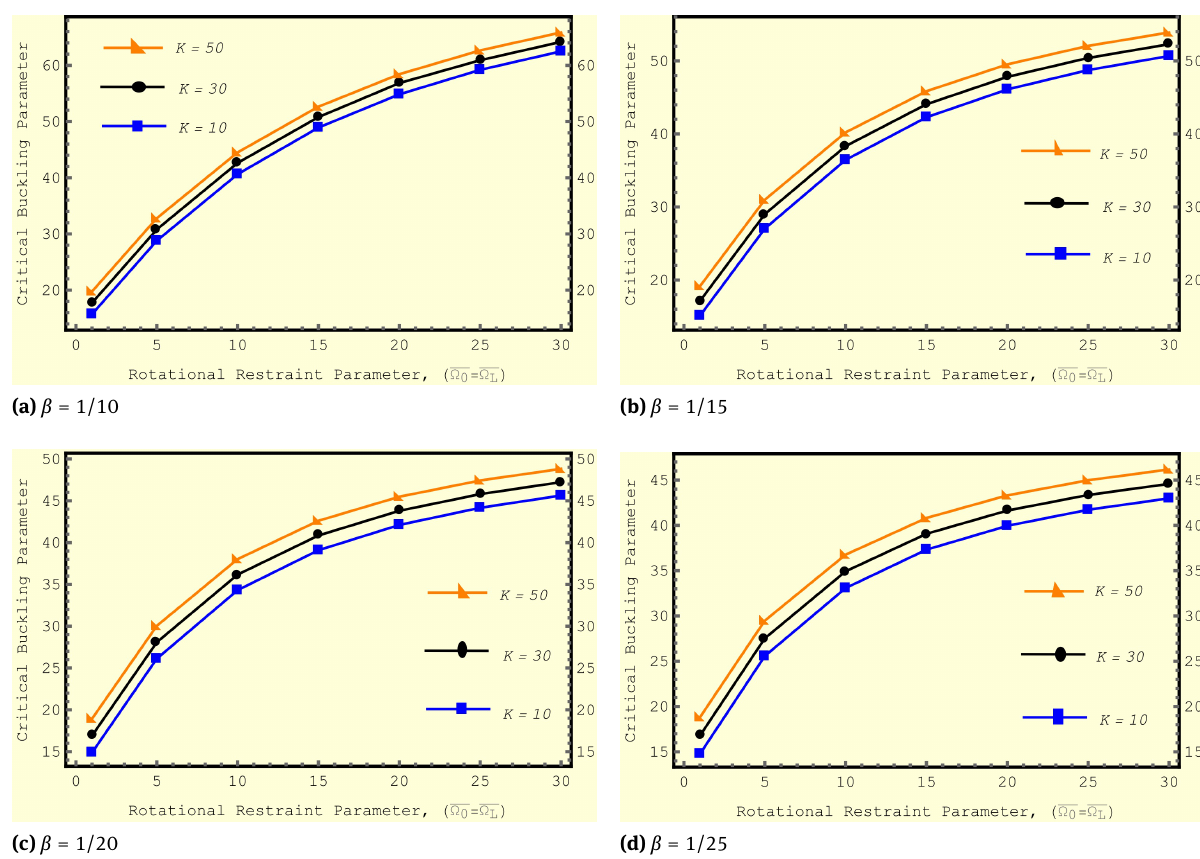
Figure 6: Effects of elastic springs on the critical buckling loads for different elastic medium parameter